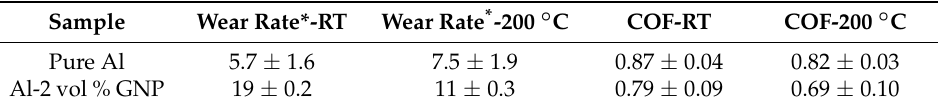
Table 1. Wear Rate and Coefficient of Friction (COF) of Sintered Pellets at RT and 200 °C.